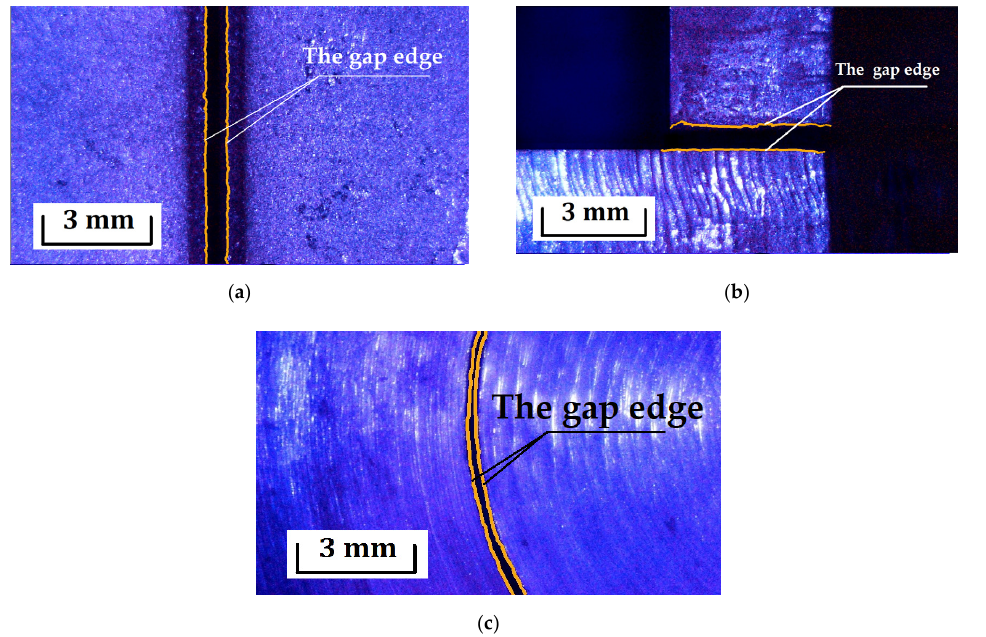
Figure 16. The result of recognition of the gap of welded workpieces in the image obtained from the CCD camera LRC-W with used value parameter recognition: ( a ) w = 65 ϕ = 5, µ 0 = 0.4, k 0 = 0.1, k 1 = 0.7; ( b ) w = 55 ϕ = 8, µ 0 = 3.5, k 0 = 0.5, k 1 = 0.5; ( c ) w = 30 ϕ = 11, µ 0 = 0.4, k 0 = 0.1, k 1 =